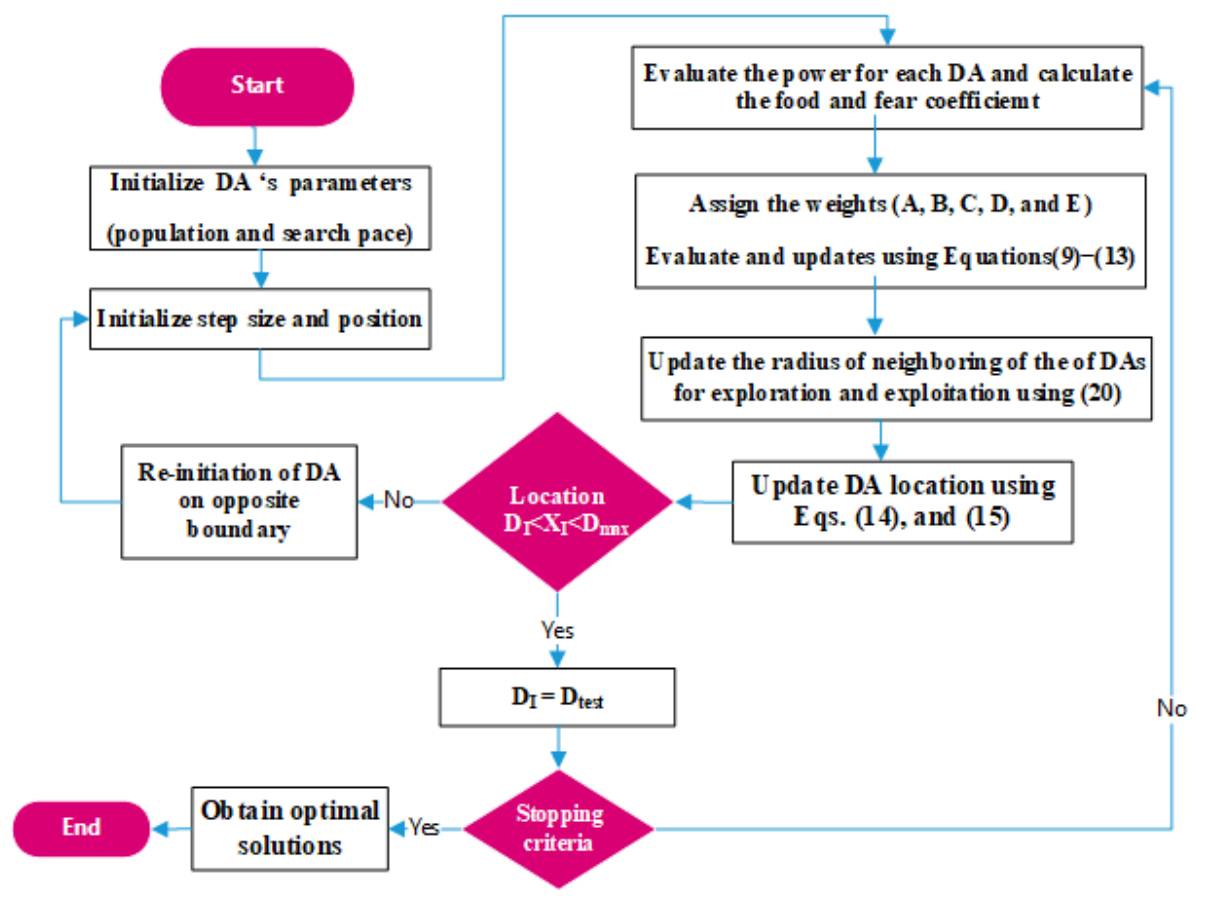
Figure 4. Dragonfly Algorithm (DA) Implementation. Table 2. DA’s parameters.